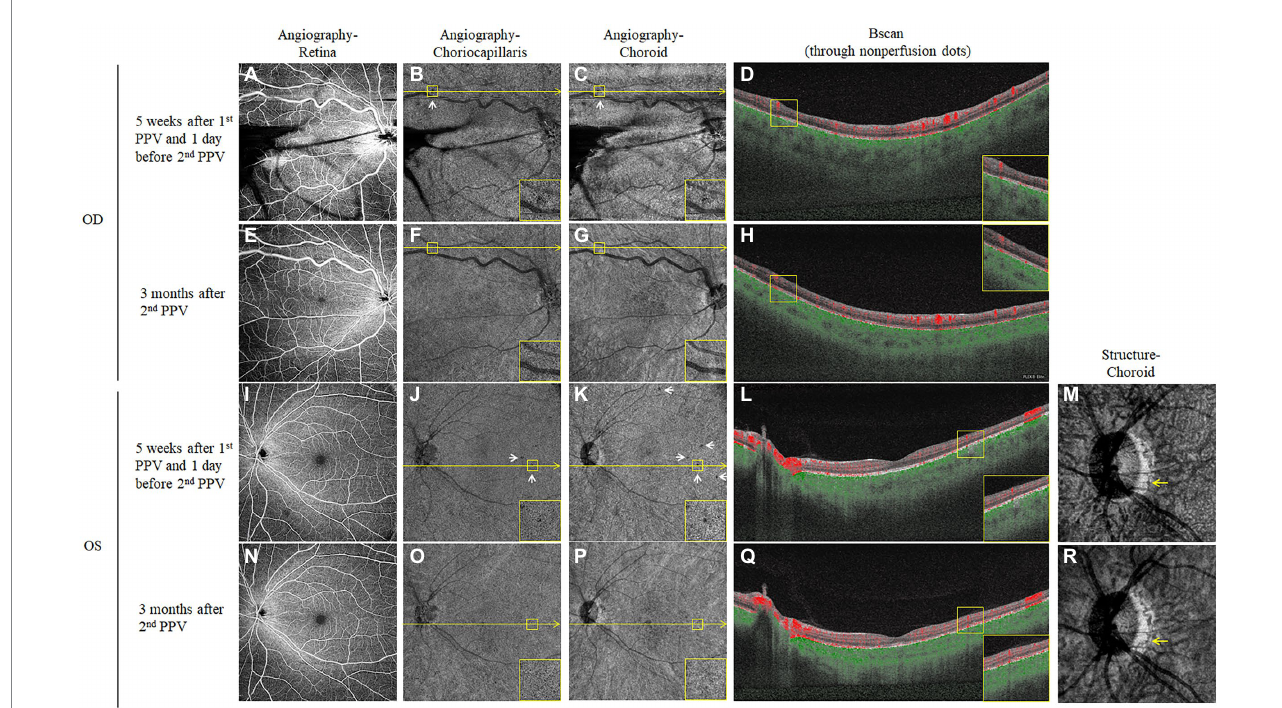
FIGURE 3 Choroidal vascular changes detected by OCTA after the first PPV and after corticosteroid treatment. Five weeks after the first PPV, the en-face OCTA slabs of the retina were mainly normal for both eyes (A,I) , except for the shadowing effects of the vitreous hemorrhage in the right eye. However, the en-face OCTA slabs of both the choriocapillaris (B,J) and choroid (C,K) showed scattered dark spots (White arrows, yellow boxes in the corners of the panel contain magnified views). The B scan images (D,L) were taken along the level of the yellow line through the dark dots, which confirmed flow voids in the choriocapillaris and inner choroid layer (Yellow boxes in the corners of the panel contain magnified views). The choroid en-face structural slab of the left eye also showed an absence of choroidal vessels in the parapapillary area ( M , yellow arrows). Three months after the second PPV and sustained oral corticosteroid treatment, the OCTA examination was repeated for both eyes. The retinal angiographies were still normal (E,N) , the dark dots at the choriocapillaris (F,O) , and choroid (G,P) levels disappeared at the corresponding locations. The follow-up B scans (H,Q) at the positions where the dark dots had been (yellow lines) demonstrated the recovery of the bloodstream signal (Yellow boxes in the corners of the panel contain magnified views). The choroidal vessels also reoccurred on the follow-up choroid en-face structural slab of the left eye ( R , yellow arrows).